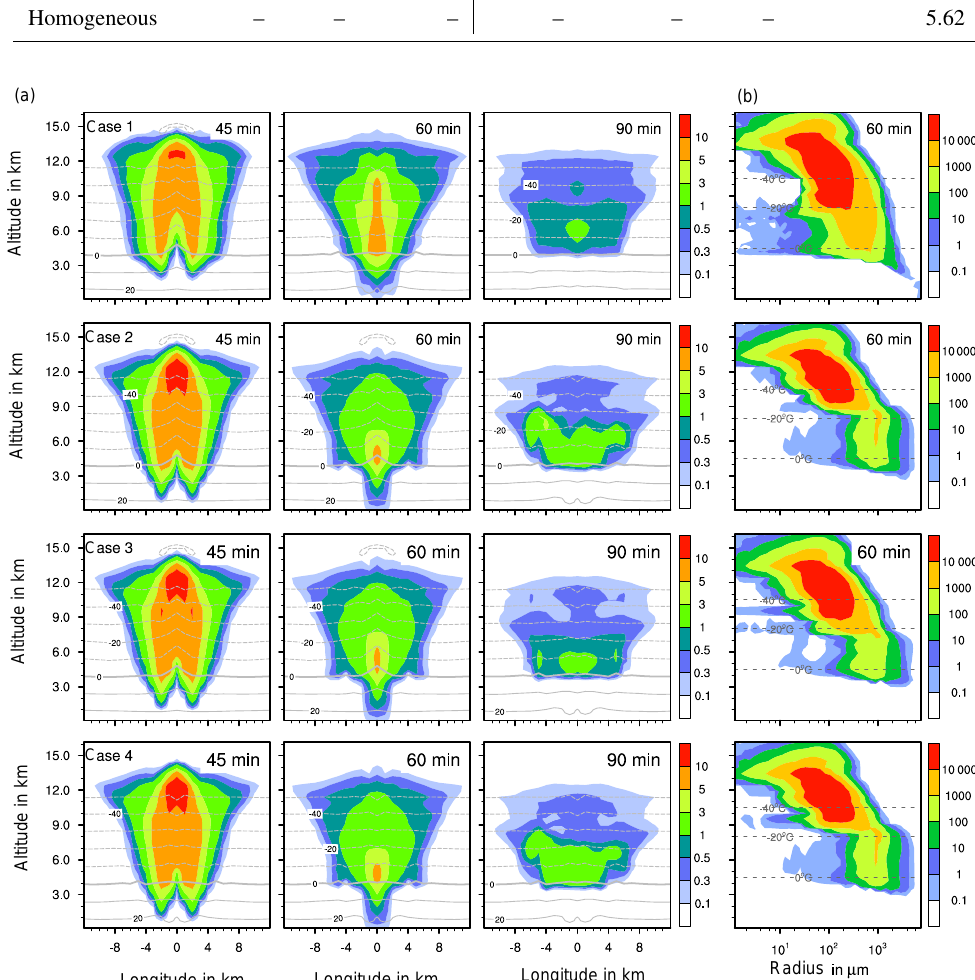
Figure 9. Ice formation for different cases with coupled homogeneous and one heterogeneous freezing mode. Case 1: immersion freezing with 1% feldspar; case 2: immersion freezing with 0.001% plant debris; case 3: contact freezing with 1% feldspar; case 4: deposition nucleation with 1% Saharan dust. (a) Ice water content in gkg − 1 at different times shown in a vertical cut through the cloud center. Horizontal dashed lines: temperature in ◦ C. (b) Ice particle size spectra in the center cell of the cloud. Number concentrations per m 3